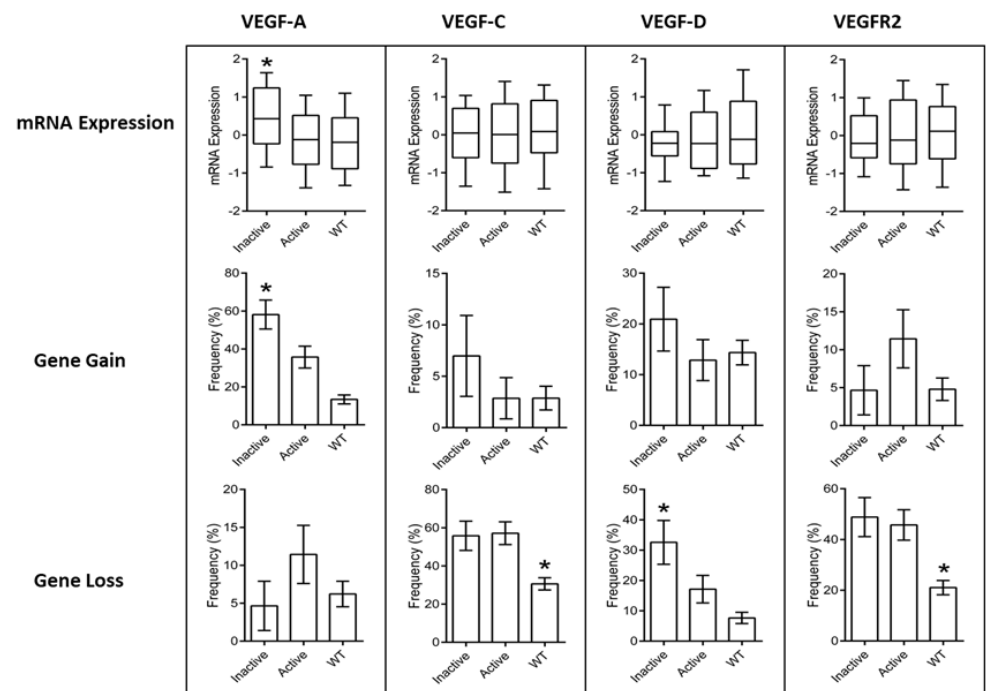
Figure 4. Plots of vascular endothelial growth factor (VEGF)/VEGF receptor 2 (VEGFR2) analysis in gastric cancer tissues. Data were collected from the TCGA PanCancer Atlas. * indicates statistically significant differences between groups as described in the text.